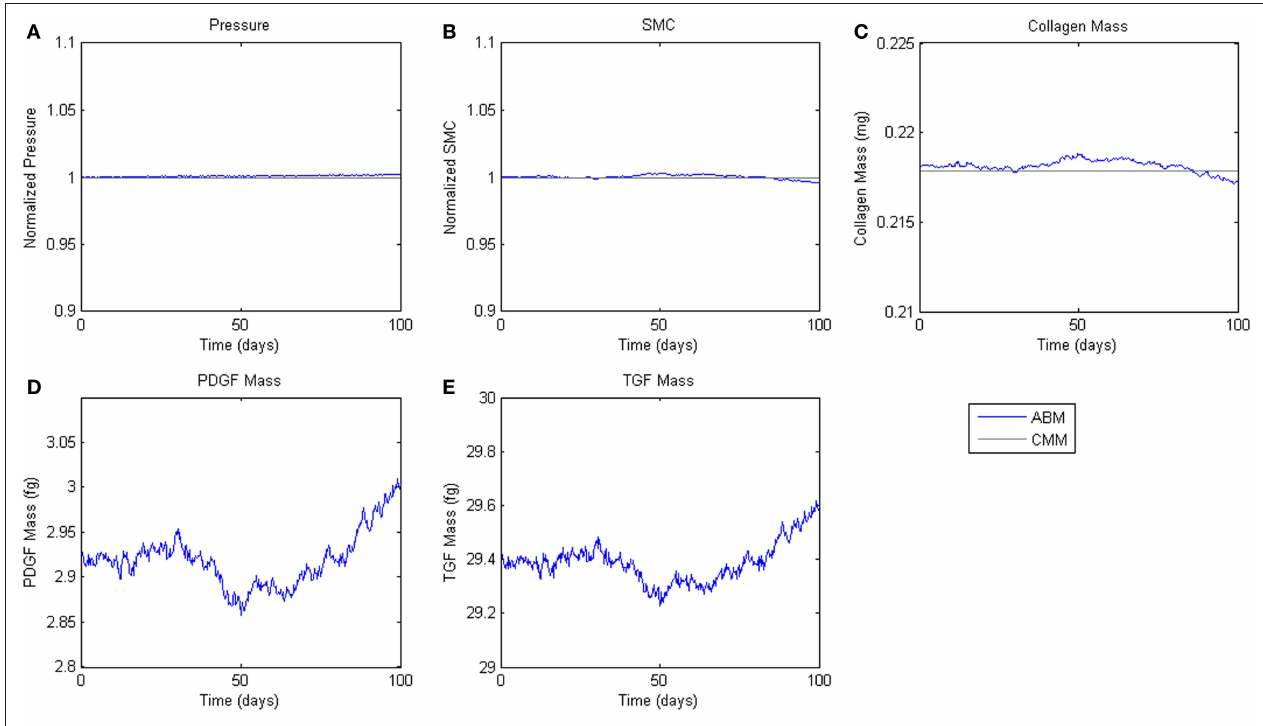
Figure 4 | homeostatic conditions. ABM results are shown in blue, CMM results in black. ABM results are an average of 100 simulations. Stochastic fluctuations in cell number lead to some changes in stress and growth factor production. Overall change in cell number is < 1%. (A) Pressure, (B) SMC, (c) Collagen, (D) PDGF-AB, (e) TGF- β